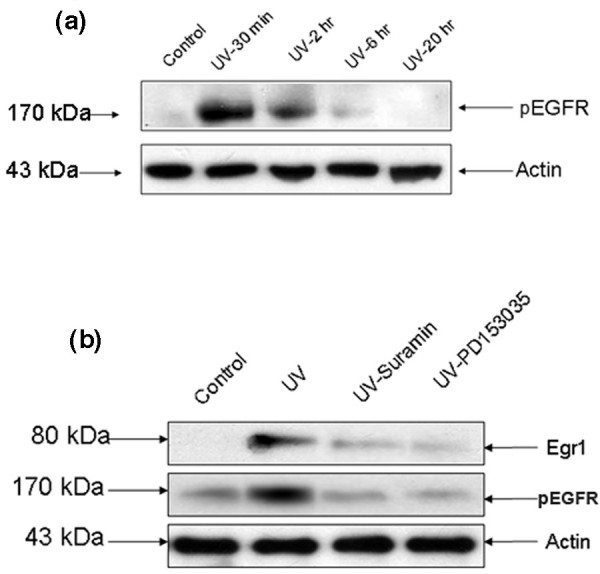
EGFR activation upon UV stimulation. (a) After 40 J/m2 UV-C radiation, 100 μg of the protein lysate was used for immunoprecipitation with EGFR antibody and this sample was used for immublotting with pTyr antibody showing activated EGFR. pEGFR, phosphorylated EGFR. (b) Western blot analysis of M12 cells treated with suramin or PD153035 for 45 minutes followed by UV-C irradiation.